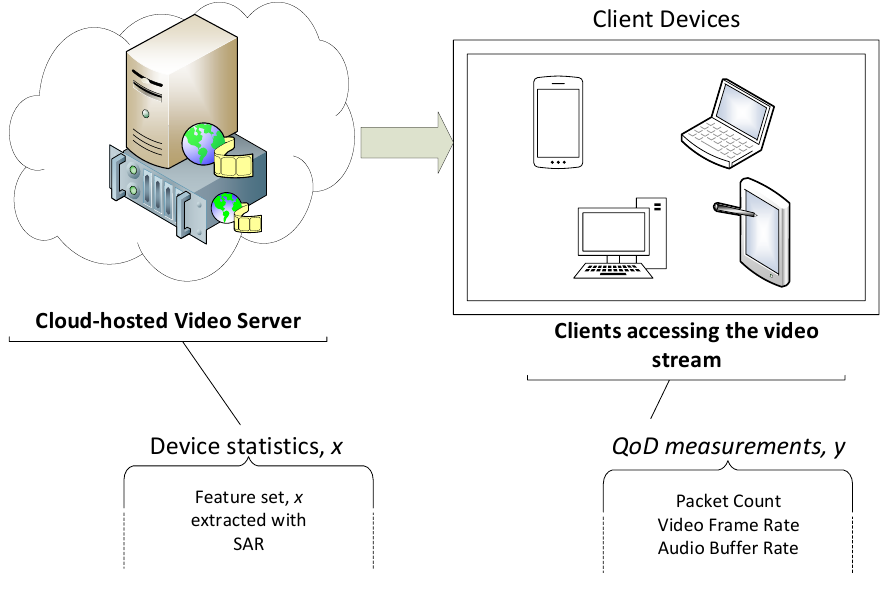
Figure 5. Client devices access video streams served by cloud-hosted servers. Device statistics, feature set x , are collated from the servers using SAR; ML models are used for the prediction of QoD measurements, y